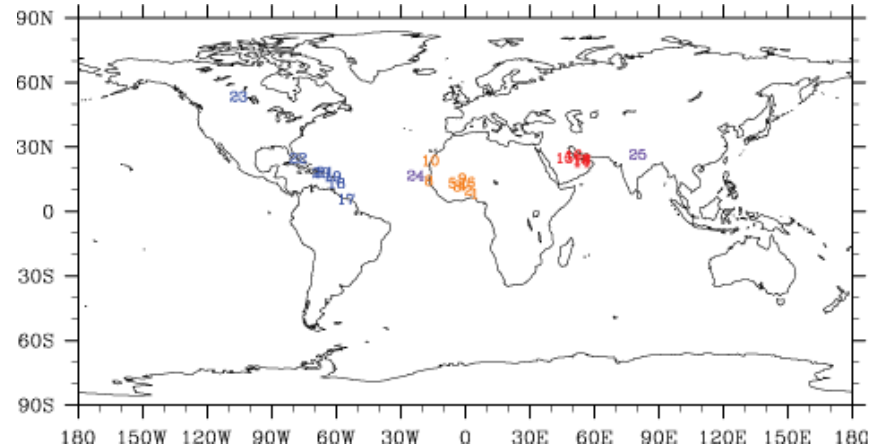
Fig. 4. Location of “dusty” sites selected from AERONET according to the data in years 1996–2006. Sites are divided into four groups: Middle East (red), Africa (orange), Caribbean-America (blue) and elsewhere in the world (purple). Name, latitude and longitude of each site are listed in Table